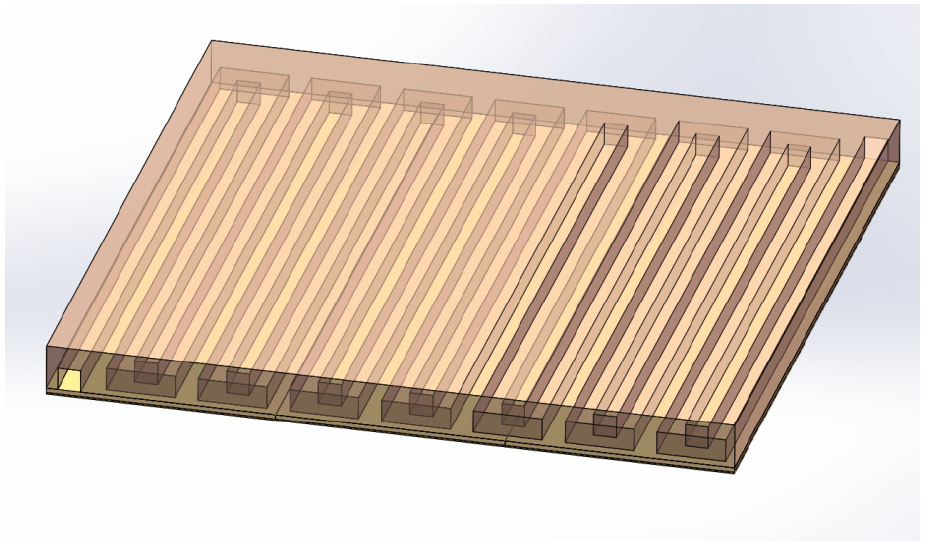
Figure 1. Schematic diagram of the PEMFC anode structure. Table 1. Structural parameters of PEMFC.